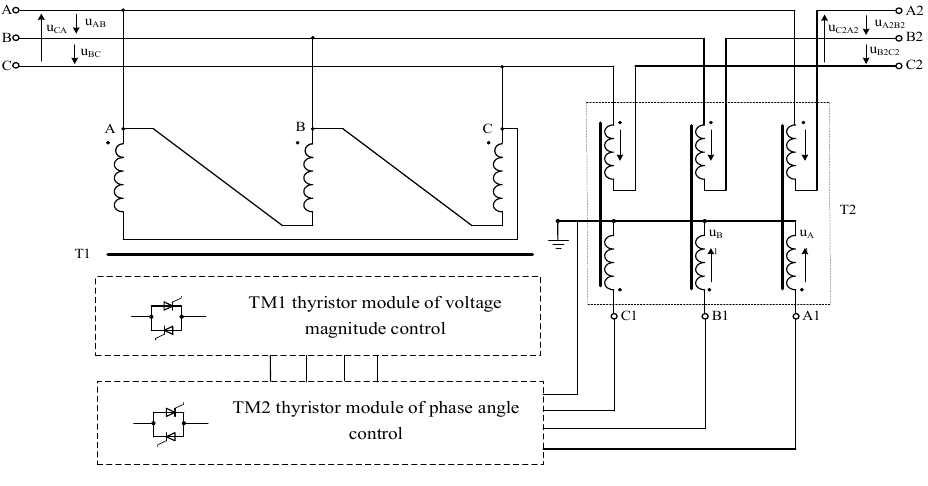
Figure 2. TVR electrical circuit diagram.